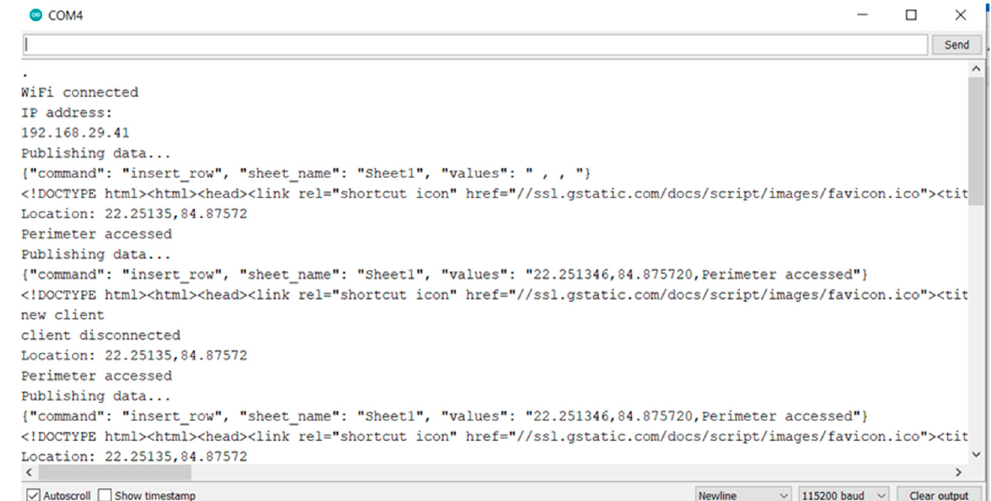
Figure A5. COM window of Arduino IDE showing the publishing of individual GPS data .